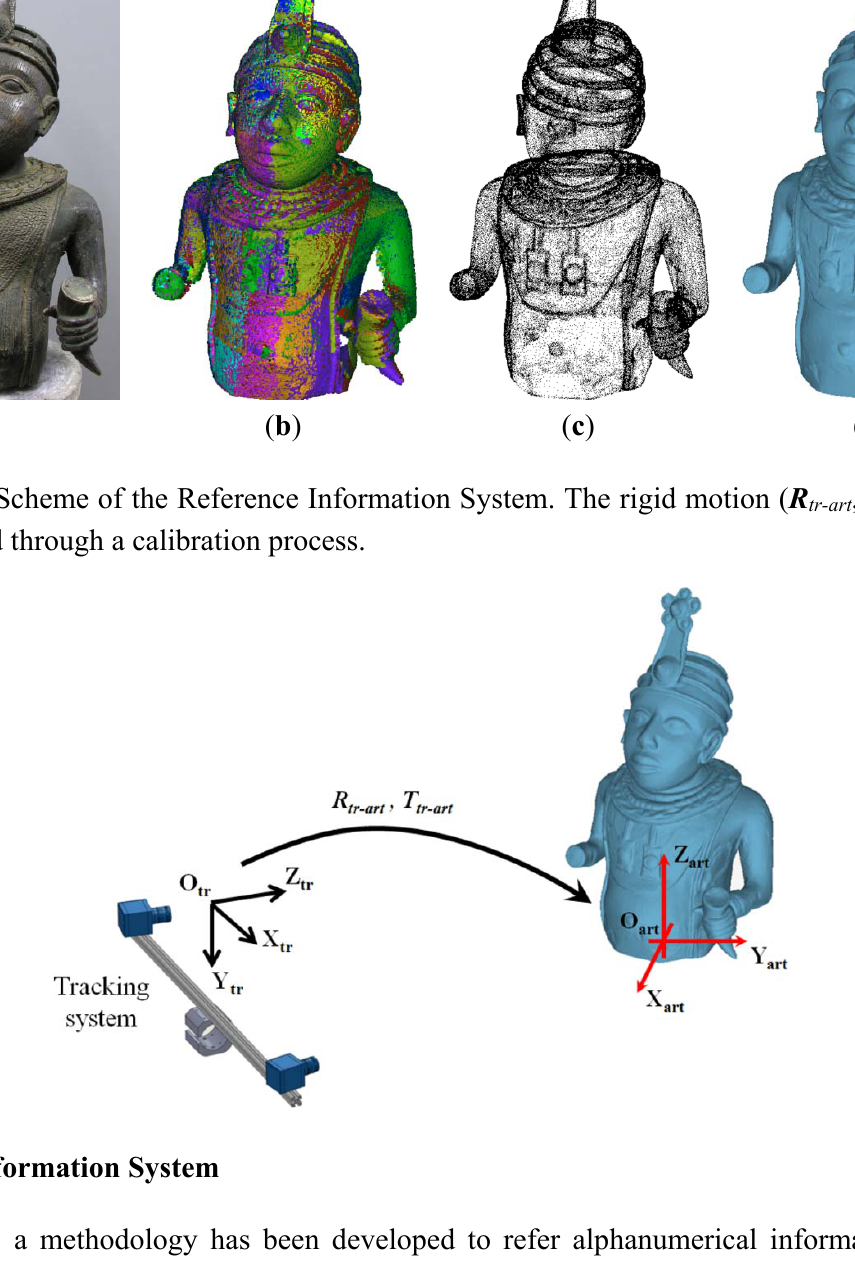
Figure 6. ( a ) Bronze model of an African bust. ( b ) Alignment of 48 different range maps. ( c ) Merging and sampling of the captured data. ( d ) StL final model.